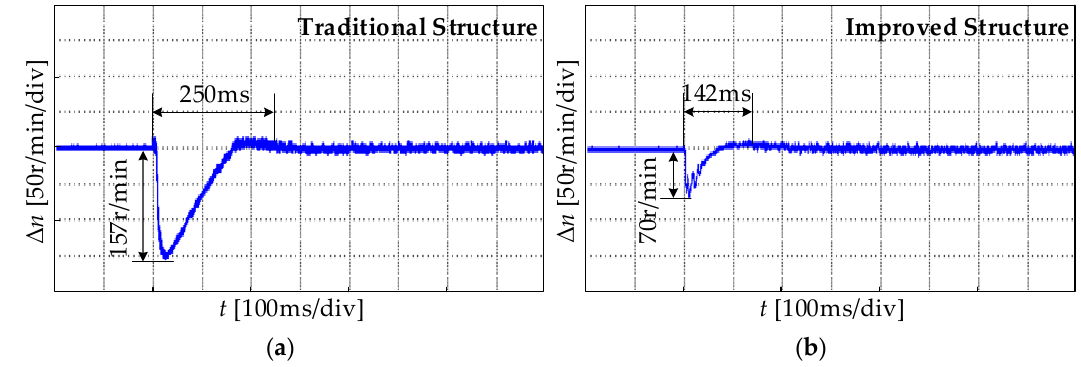
Figure 13. Synchronization error during the start-up of motors with load: ( a ) Synchronization error in the traditional structure; ( b ) Synchronization error in the improved structure.